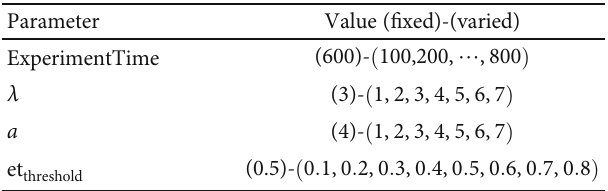
Table 2: Parameters for experiment studies. Parameter Value ( fi xed)-(varied)